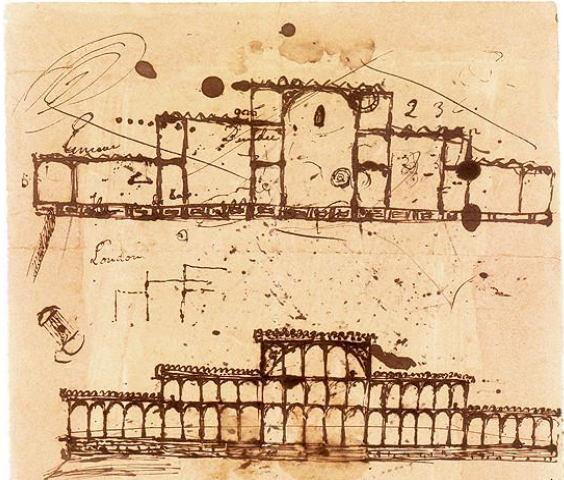
Figure 2 : First sketch for the Great Exhibition Building by Sir Joseph Paxton (1850). Figure 3 : The Crystal Palace in Hyde Park for Grand International Exhibition of 1851. Between May and October 1851 millions